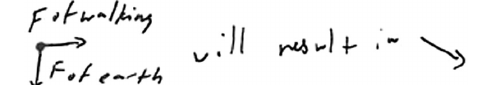
FIG. 5. Diagram accompanying student response to walking person dropping ball